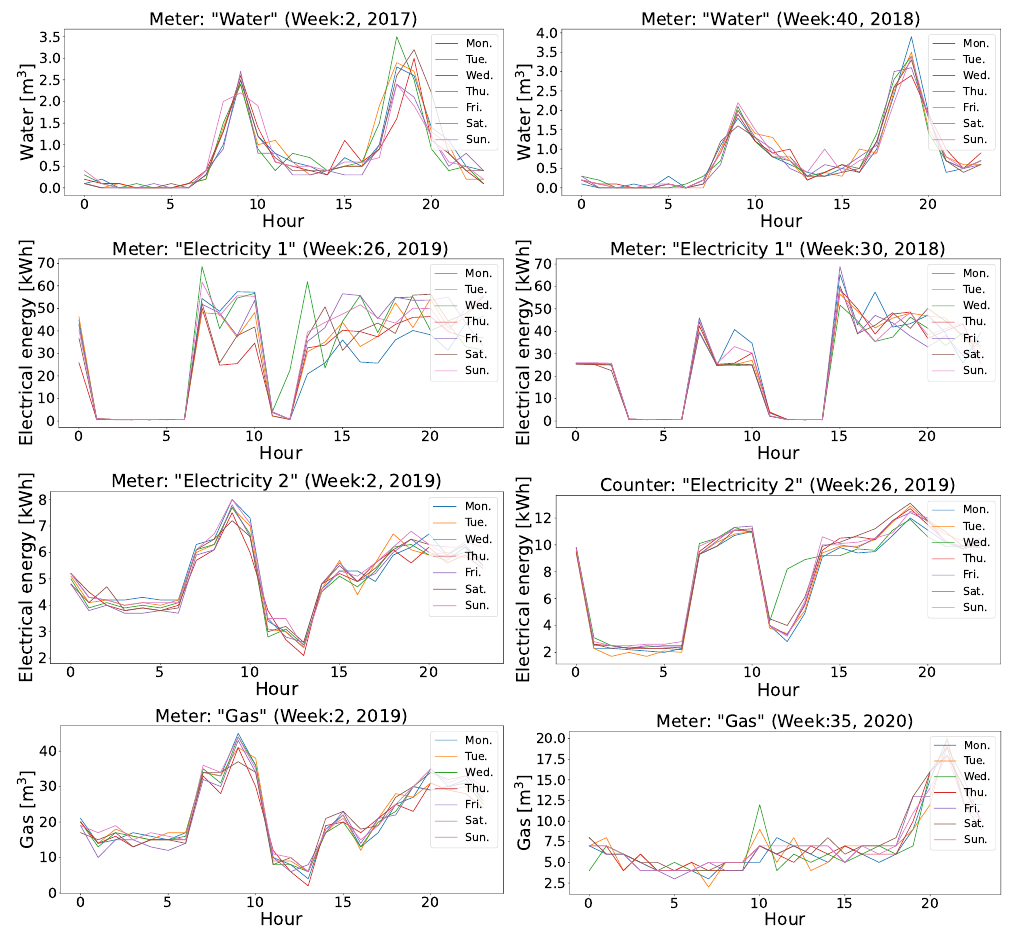
Figure 11. Representations of daily consumption in different days of a week, for the 4 m under